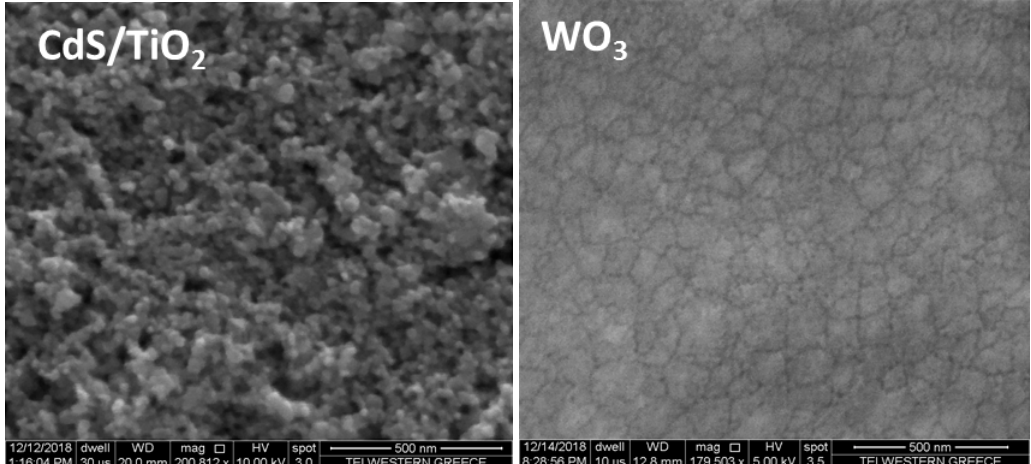
Figure 4. SEM images of the photocatalyst films used to construct photoanodes in the present